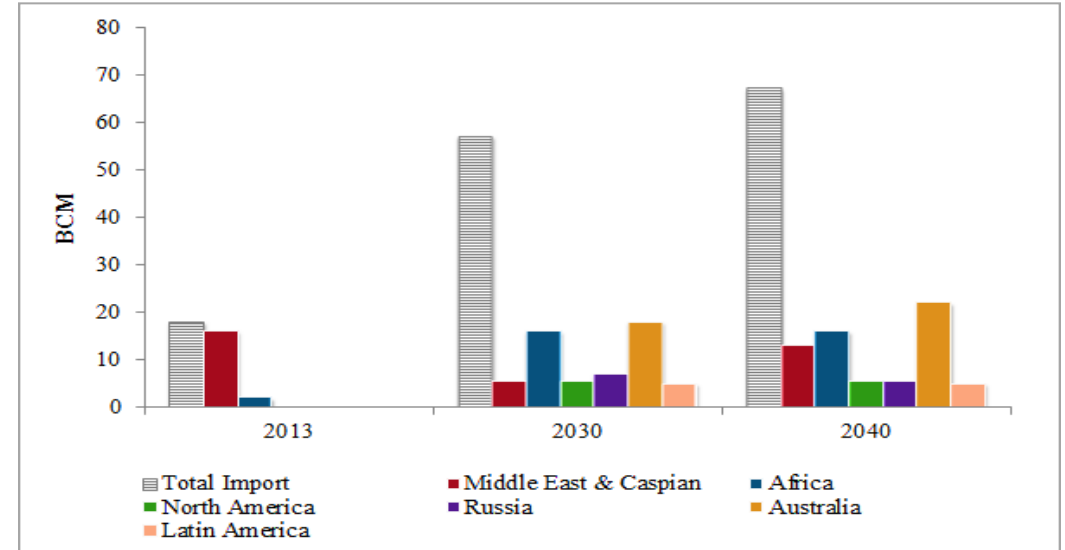
Figure 6. India’s natural gas imports through LNG under the New Policies Scenario of India Energy Outlook, 2015; Figure prepared based on partial data extracted from Fig. 3.14 of India Energy Outlook, 2015 [32]. Tables 5 and 6, respectively, provide the data used and calculations of HHI, SWI, and SWN for 2013 and the projection for 2030. HHI, SWI, and SWN indices are calculated to be 0.8, 0.44, and 2.01, respectively, for the years 2013–2014. This clearly shows a very high market concentration, owing to ~89% import share of the Middle East and Caspian region. Table 5. India’s Energy Security Indicators with respect to the importation of natural gas (2013–14). Continents/Sub- continents